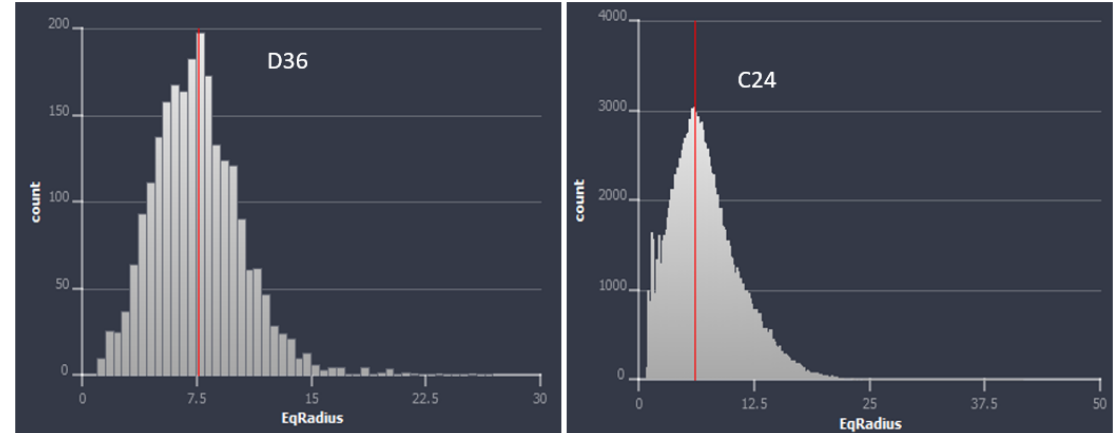
Figure 21. Pore throat size distribution in the range of 1–20 µ m. On the y-axis is the count (frequency) and the x-axis is the corresponding equivalent radii (EqRadius in µ m) of the pore throats.